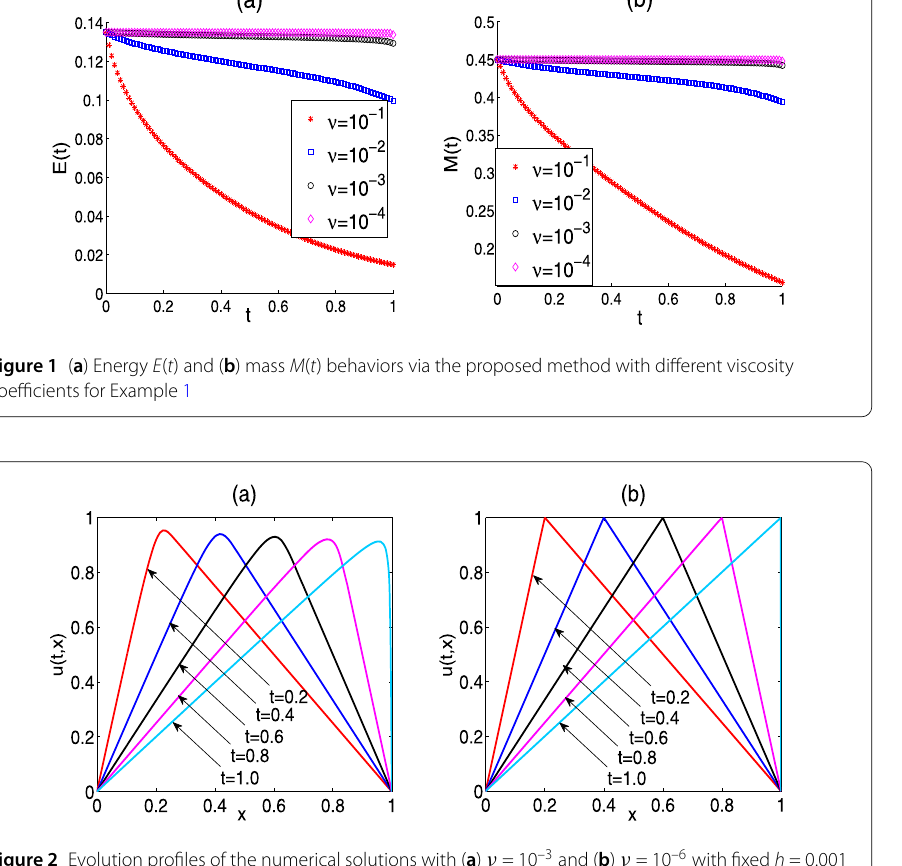
Figure 2 Evolution profiles of the numerical solutions with ( a ) ν = 10 –3 and ( b ) ν = 10 –6 with fixed h = 0.001 and (cid:4) x = 1 for Example 1000